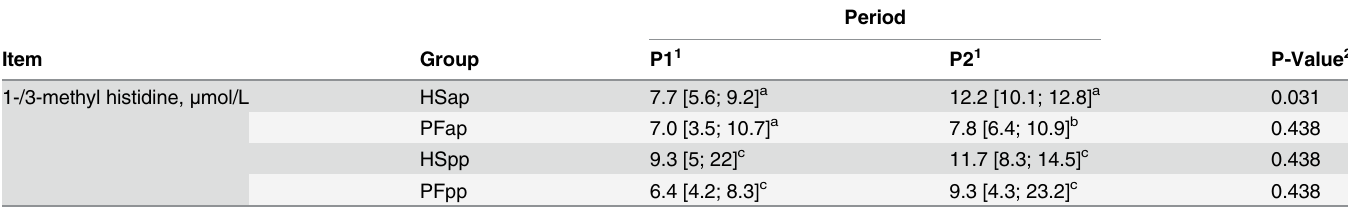
Table 4. Plasma 1-/3-methyl histidine concentrations of heat-stressed (HS) and pair-fed (PF) cows on day 6 of each